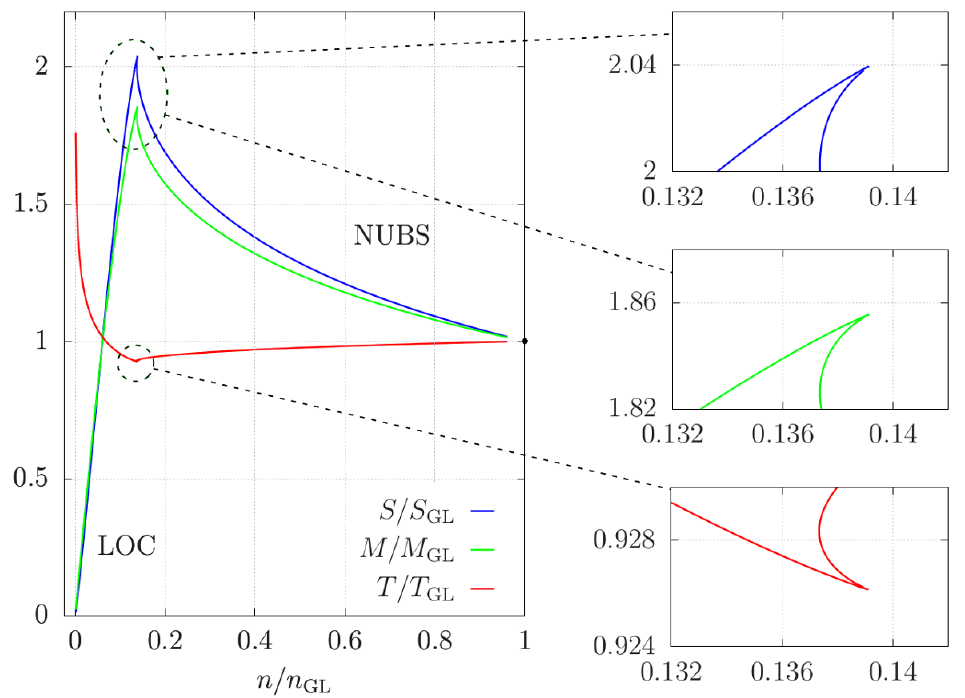
Figure 4 . Entropy, mass and temperature as a function of the relative tension, normalized with respect to the values at the GL point. The mini-plots at the right hand side correspond to zooming at the merger point, as indicated by the dashed